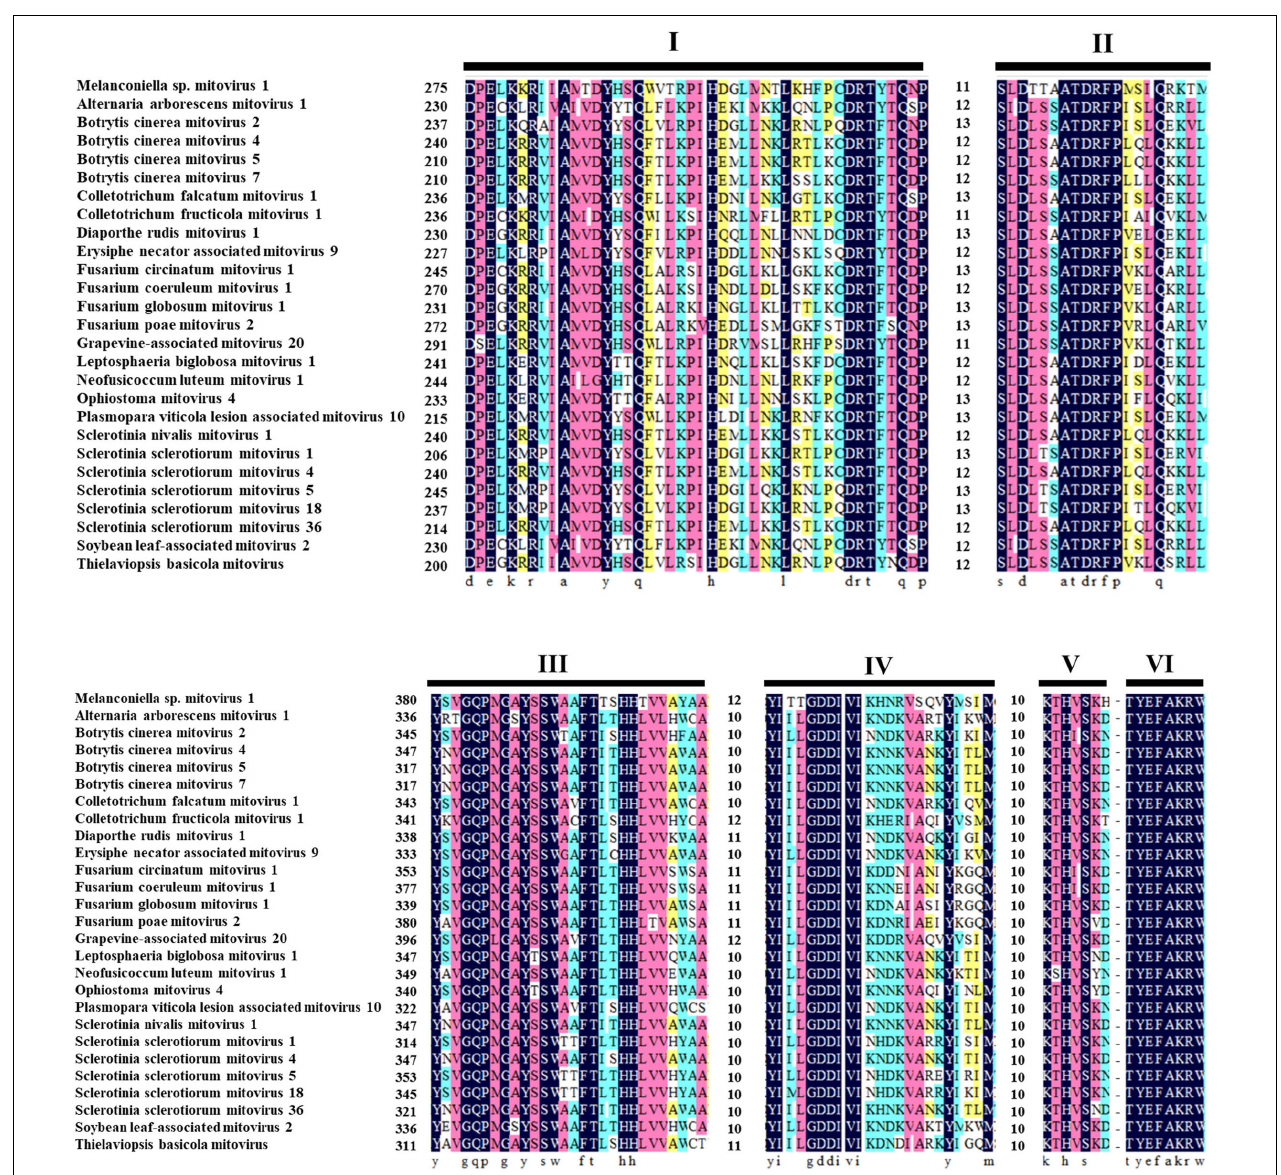
FIGURE 3 | Multiple alignments of the conserved motifs of RdRp in MtMV1 and other mitoviruses. Lines above the aligned sequences indicate to the positions of the motifs (I–VI). Numbers between every two motifs correspond to the number of aa residues separating the motifs. Identical, conserved, and semi-conserved aa residues are color-highlighted with homology level as 100% (black), 75% (magenta), 50% (turquoise), and 33%